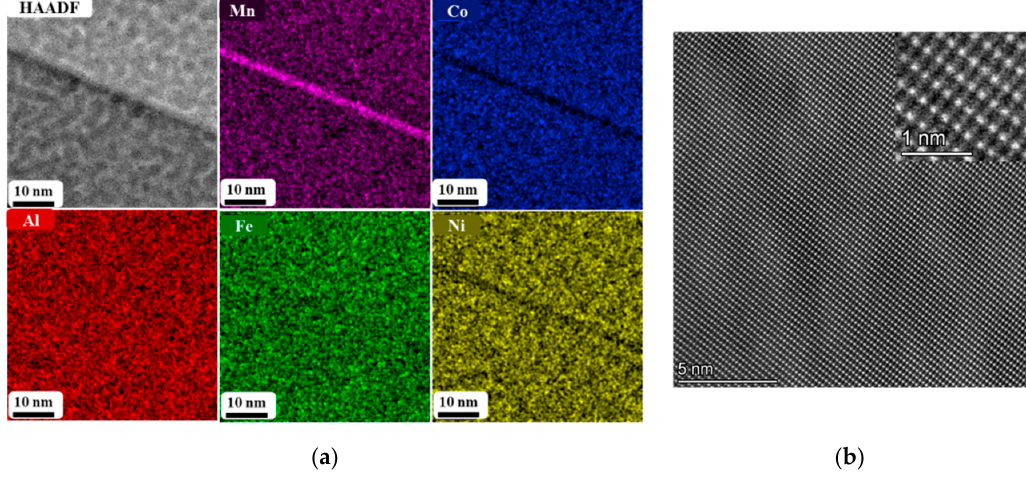
Figure 10. Aberration-corrected high angle annular dark-field (HAADF)-STEM analysis of Al(CoFeMnNi) B2 aluminide homogenized at 1373 K for 144 h shows ( a ) HAADF-STEM image and corresponding STEM-EDS elemental maps of constituent elements and ( b ) the atomically resolved HAADF-STEM image of the B2 ordered lattice. Metals 2020 , 10 , x FOR PEER REVIEW